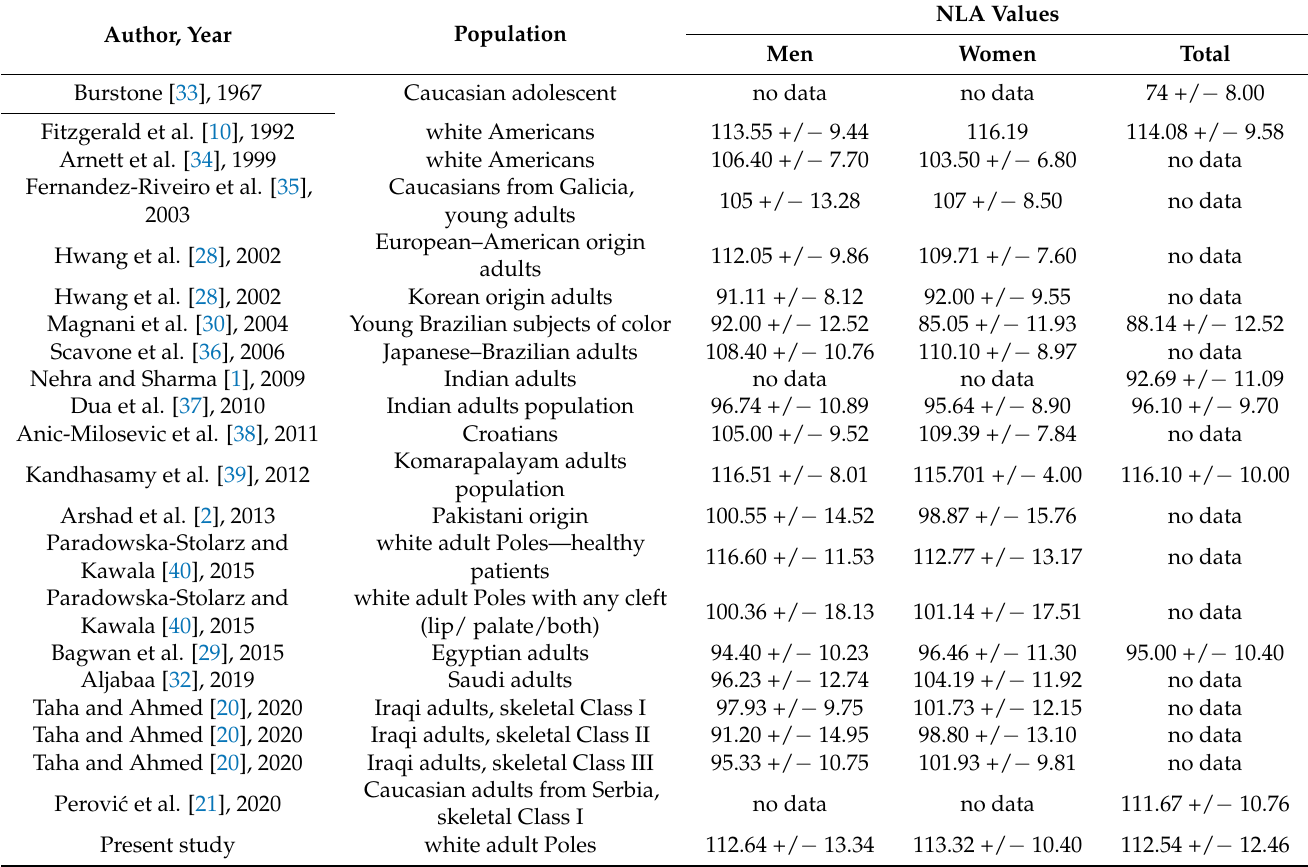
Table 6. NLA value in the